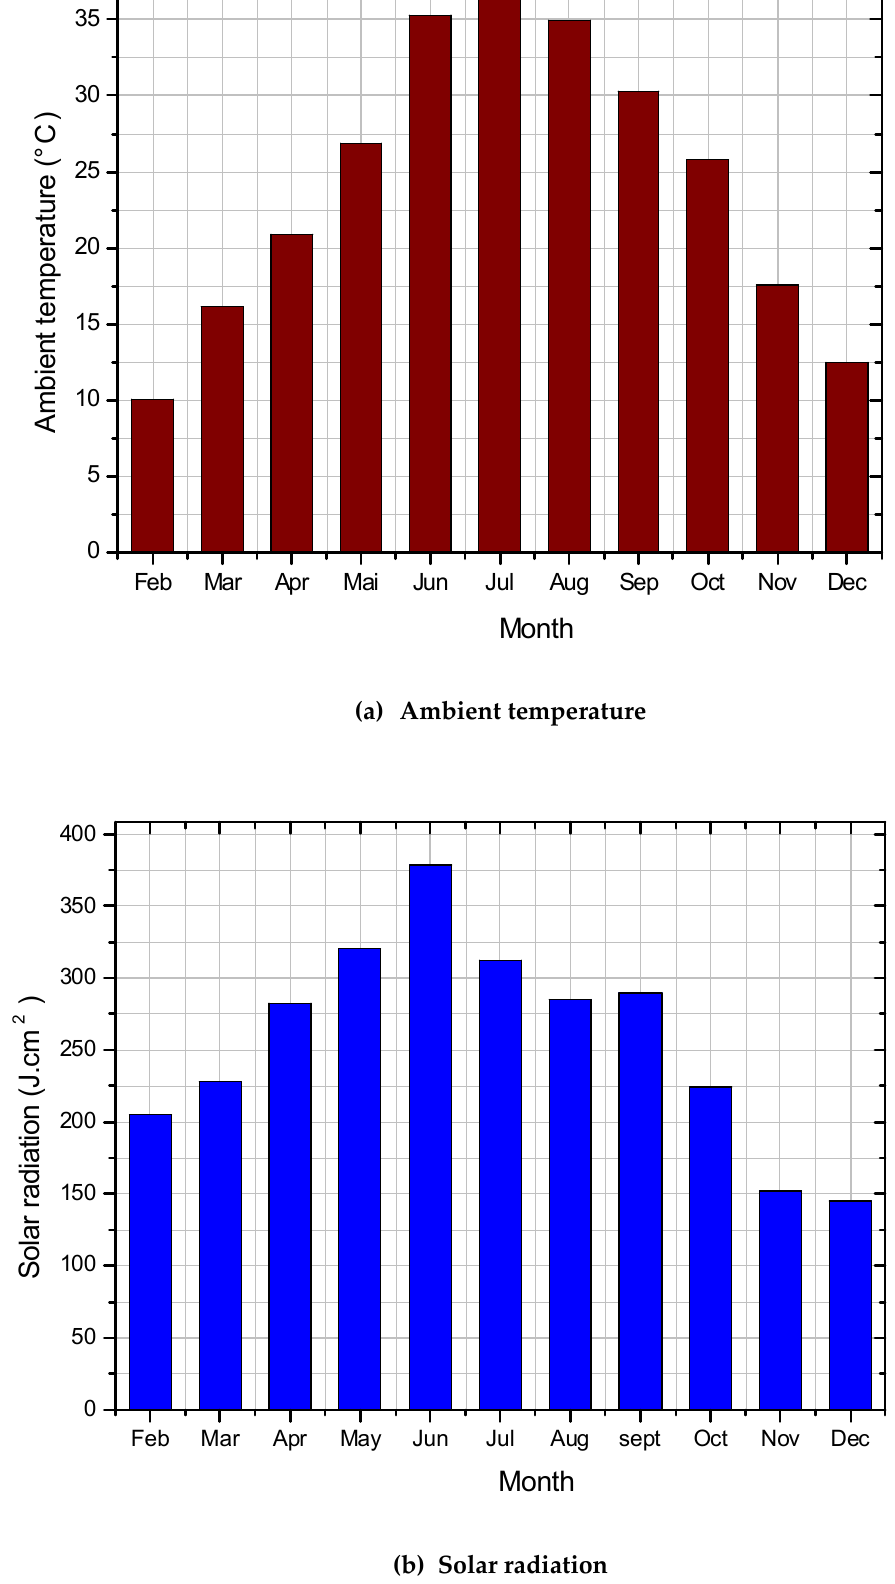
Figure 3. Annual temperature and solar radiation evolution (Ghardaïa site).